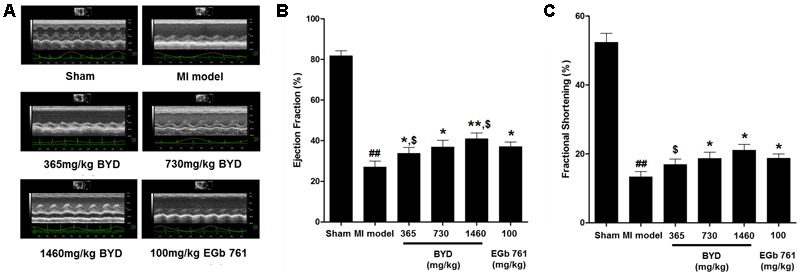
Echocardiographic assay. (A) Representative electrocardiogram recorded; (B) Values of EF (left ventricular ejection fraction); (C) Values of FS (left ventricular fraction shortening). Values are presented as means ± SD. Significance was assessed with a two-tailed Student’s t-test: ##p < 0.01 vs. the sham group; ∗p < 0.05 or ∗∗p < 0.01 vs. the MI group. $p < 0.05 vs. the positive control group.